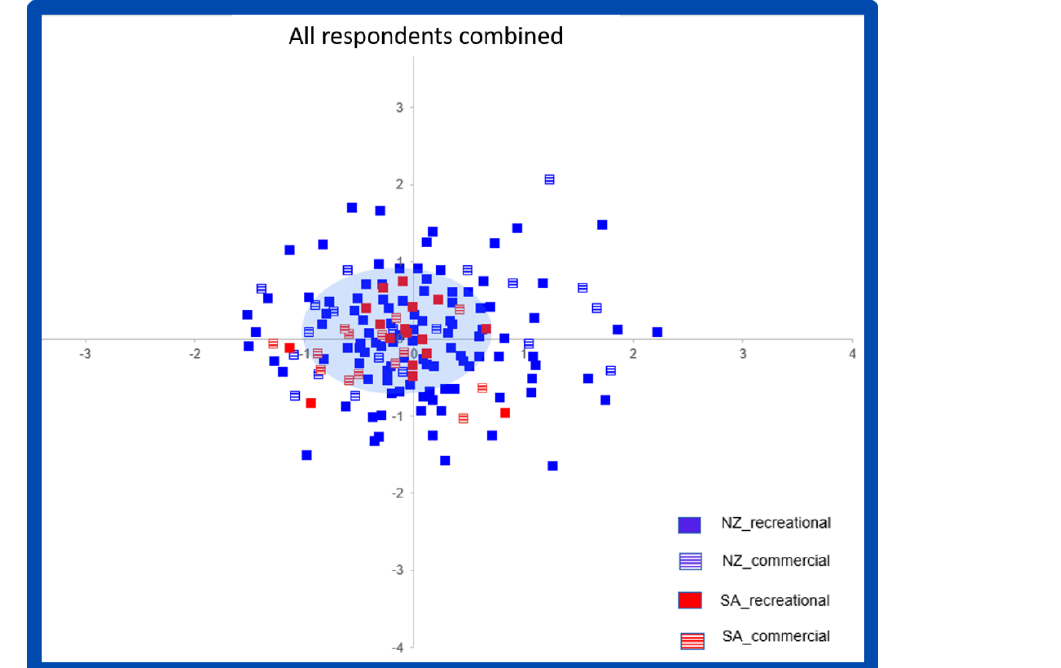
Figure 4. Nonmetric, multidimensional scaling of agreement in the whole-group analysis (stress = 0.264). The blue oval at the centre is an approximate grouping of respondents whose competence score was 0.6 or